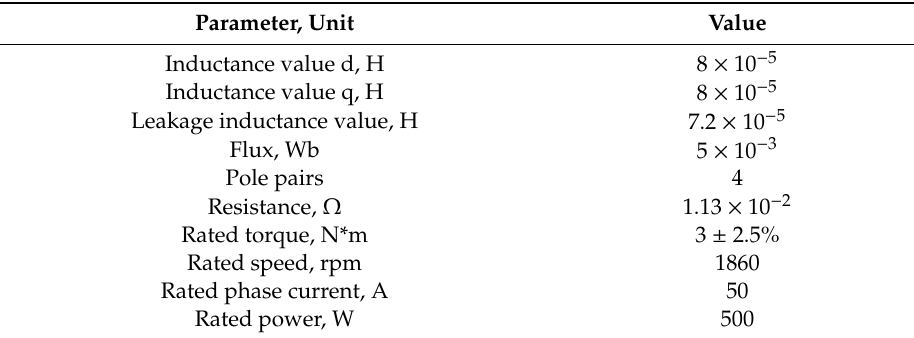
Table 1. Machine parameters.